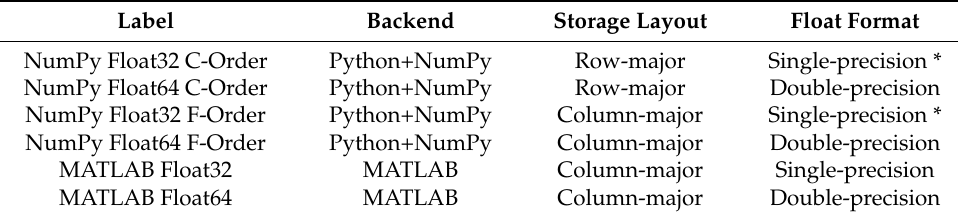
Table 3. Implementations of statistical tolerance analysis using a